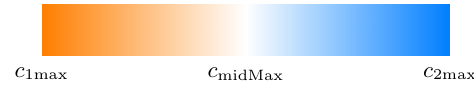
Figure 2. Bivariate color scale for c max based on ρ 1 and ρ 2